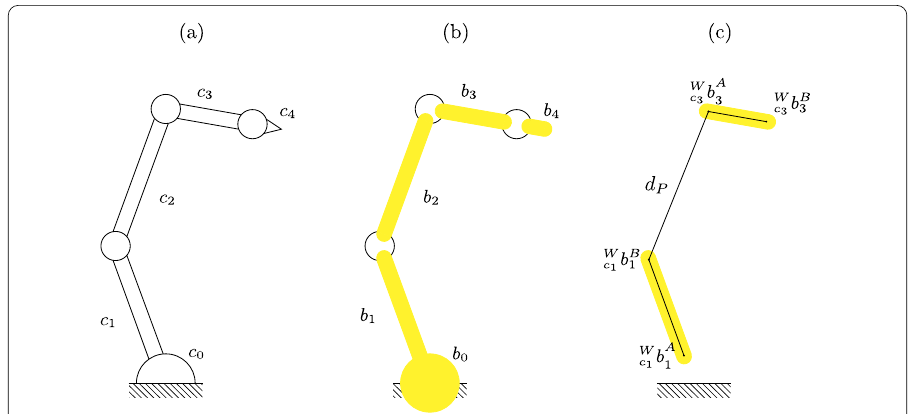
Figure 4 Visualization of the capsule approximation. Each joint c i , i ∈ { 0, ... ,4 } in column (a) is described by an appropriate capsule b i , i ∈ { 0, ... ,4 } illustrated in column (b) . In column (c) the distance d P between the two line segments b 1 and b 3 is